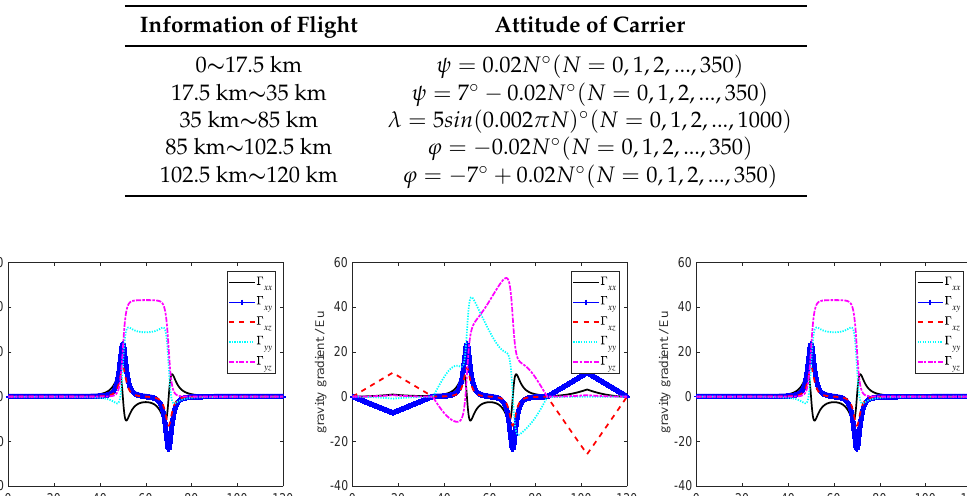
Table 2. Parameters of flight attitude for the carrier.